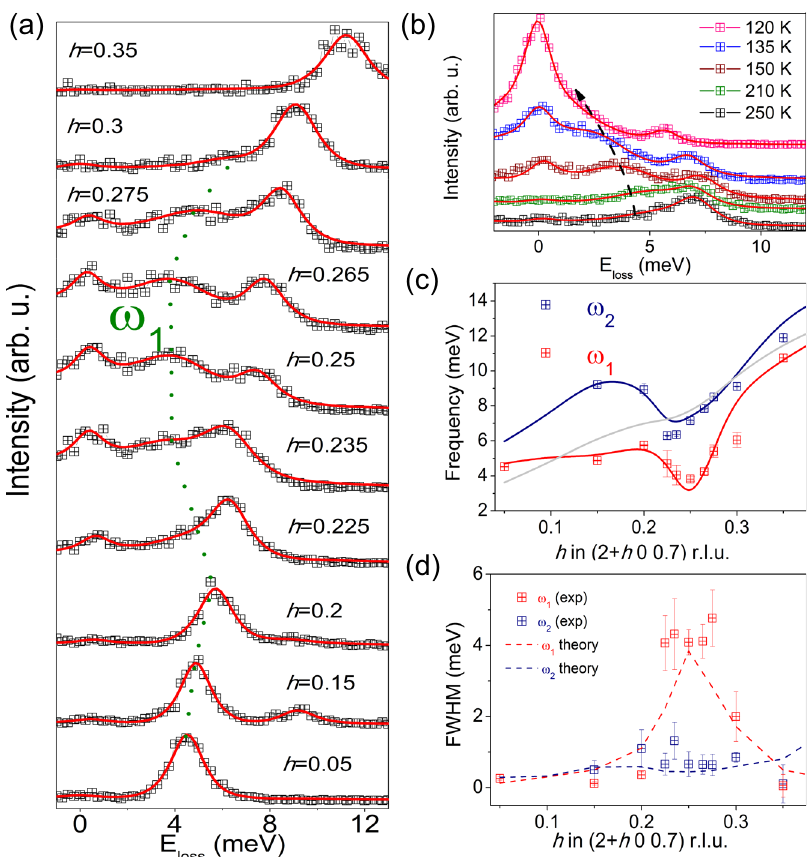
Fig. 2 Lattice dynamics at 150 K. a IXS energy-loss scans at (2 + h 0 0.7) r.l.u for 0.15 < h < 0.35 and 150 K. The dotted green line follows the dispersion of the soft phonon mode, ω 1 (see text). Each spectrum is vertically shifted for clarity. b Energy-loss scans as a function of temperature at (2.25 0 0.7) r.l.u. The black arrow follows the softening of the low-energy acoustic mode upon cooling. In both ( a ) and ( b ) red lines are the result of the fi tting to damped harmonic oscillator functions convoluted with the instrumental resolution. c Momentum dependence of the frequency of the ω 1 and ω 2 branches at 150 K. The anharmonic phonon dispersions of the acoustic modes obtained at 150 K are plotted as solid lines. The gray line represents the acoustic mode that is silent in IXS. d Experimental (symbols) and theoretical (dashed lines) momentum dependence of the linewidth for ω 1 and ω 2 . The error bars represent the fi t uncertainty. The theoretical calculation accounts for both the electron – phonon and anharmonic contributions to the